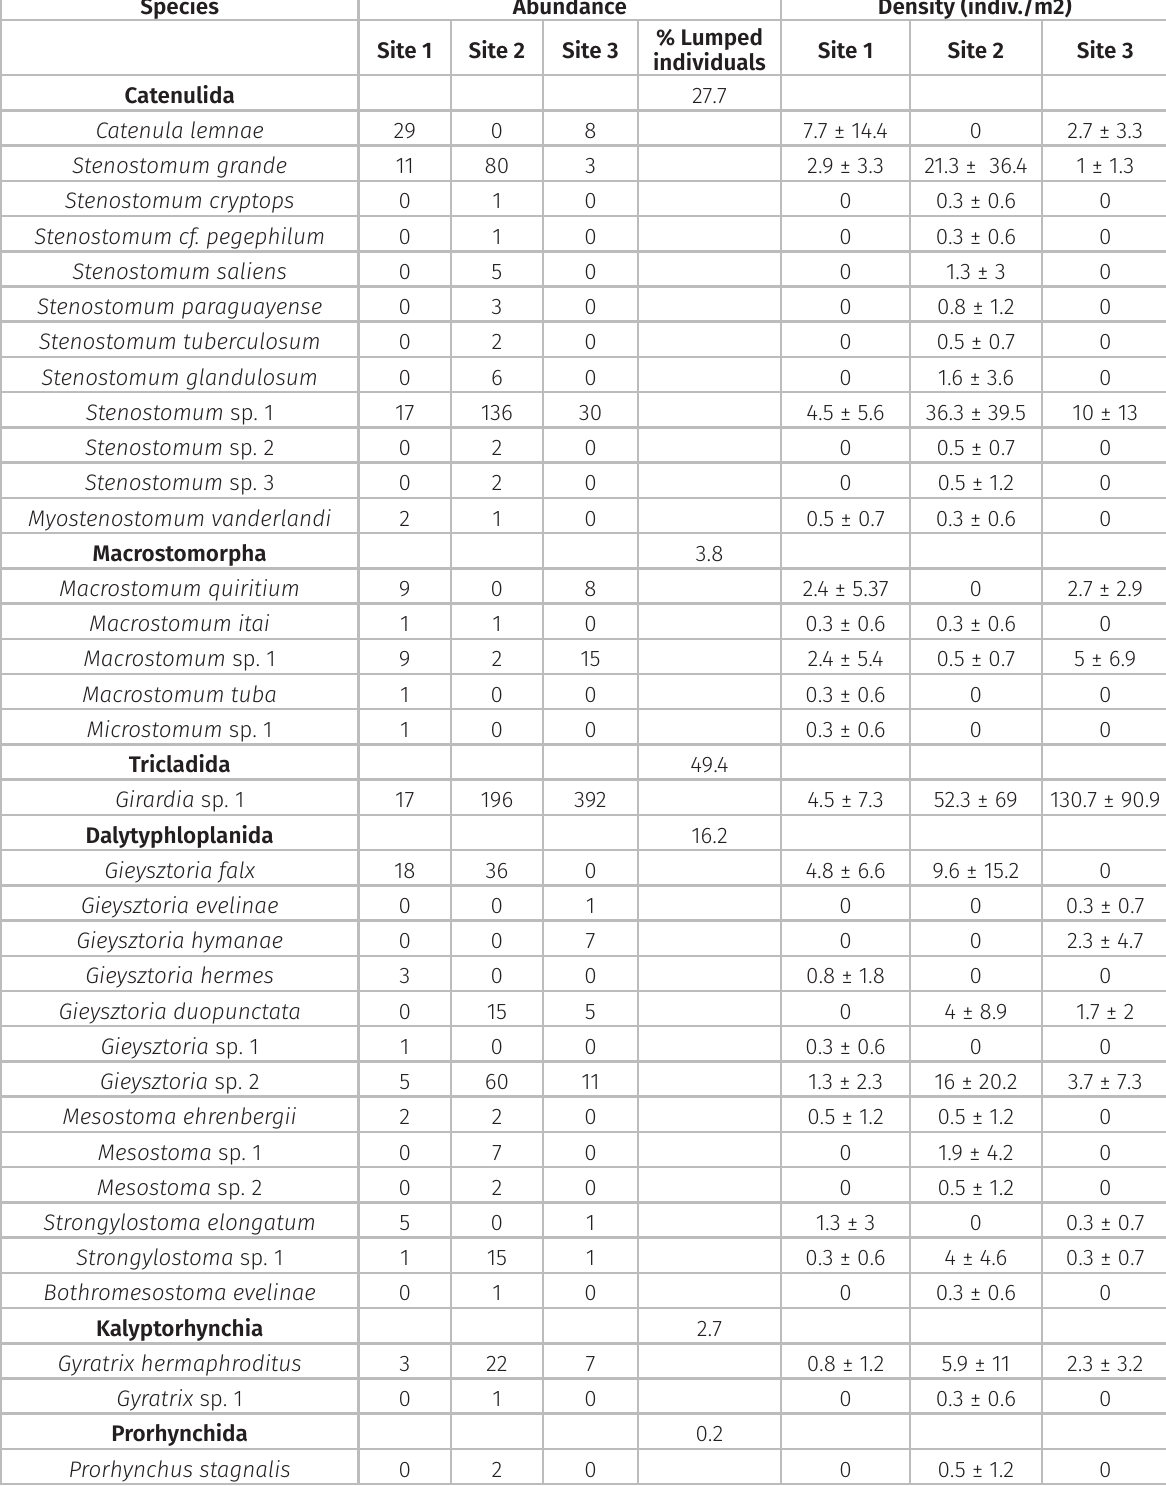
Table I. Total and relative (%) abundances, and density of Turbellaria in three floating vegetation microhabitats (S1, S2 and S3) of the ESEC